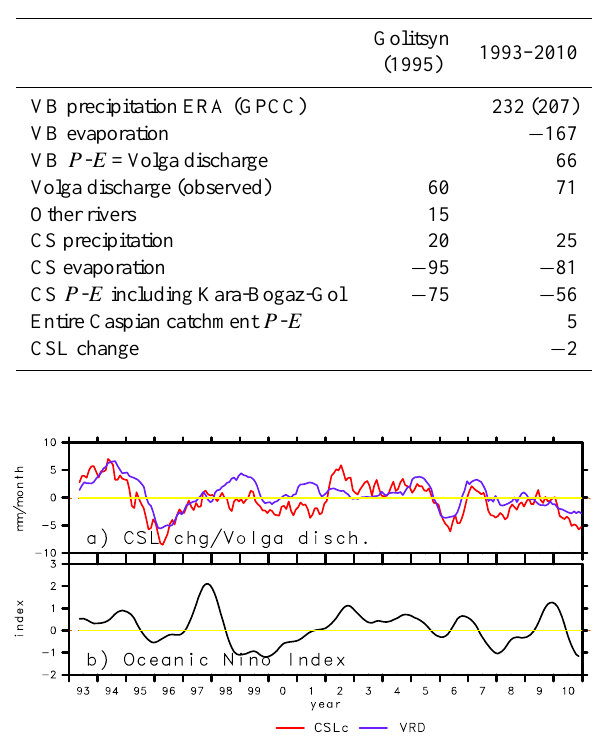
Table 1. Climatological water budget components for the Caspian Sea (CS). Units: change of the Caspian Sea level (CSL) per year in